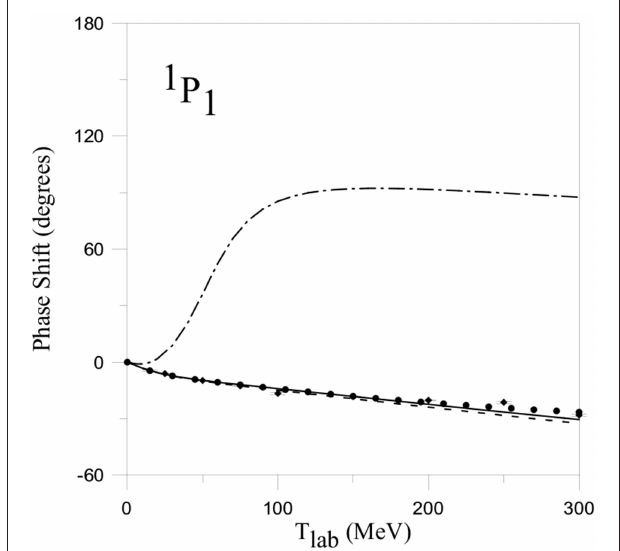
FIGURE 5 | NN 1 P 1 phase-shift. Dashed and solid lines have the same meanings as in Figure 4B . Dashed-dotted line shows the effect of antisymmetry, corresponding to the result when all the exchange kernels are removed. Reprinted figure with permission from Entem et al. [ 52] Copyright (2000) by the American Physical Society.